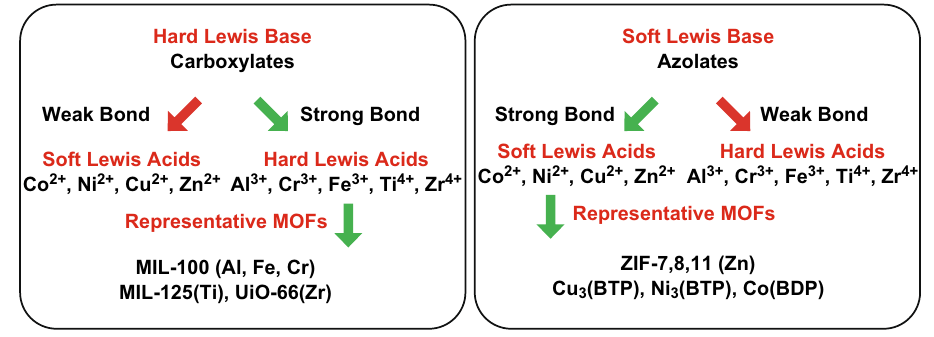
Fig. 3 Stability of MOF guided by HSAB theory. Reproduced from Ref. [27] with permission from The Royal Society of